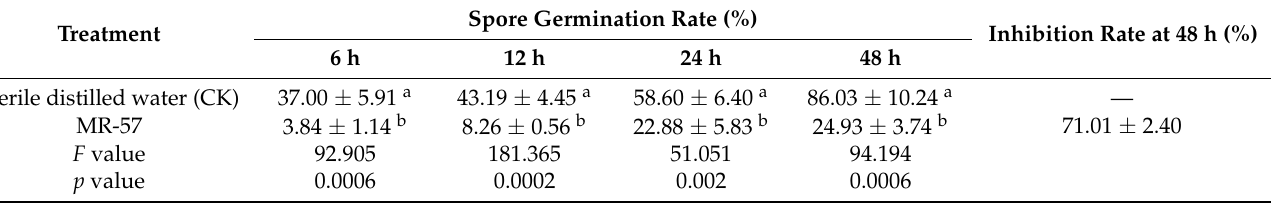
Table 1. Effects of culture filtrate of MR-57 on the spore germination of F. equiseti . Spore Germination Rate Treatment